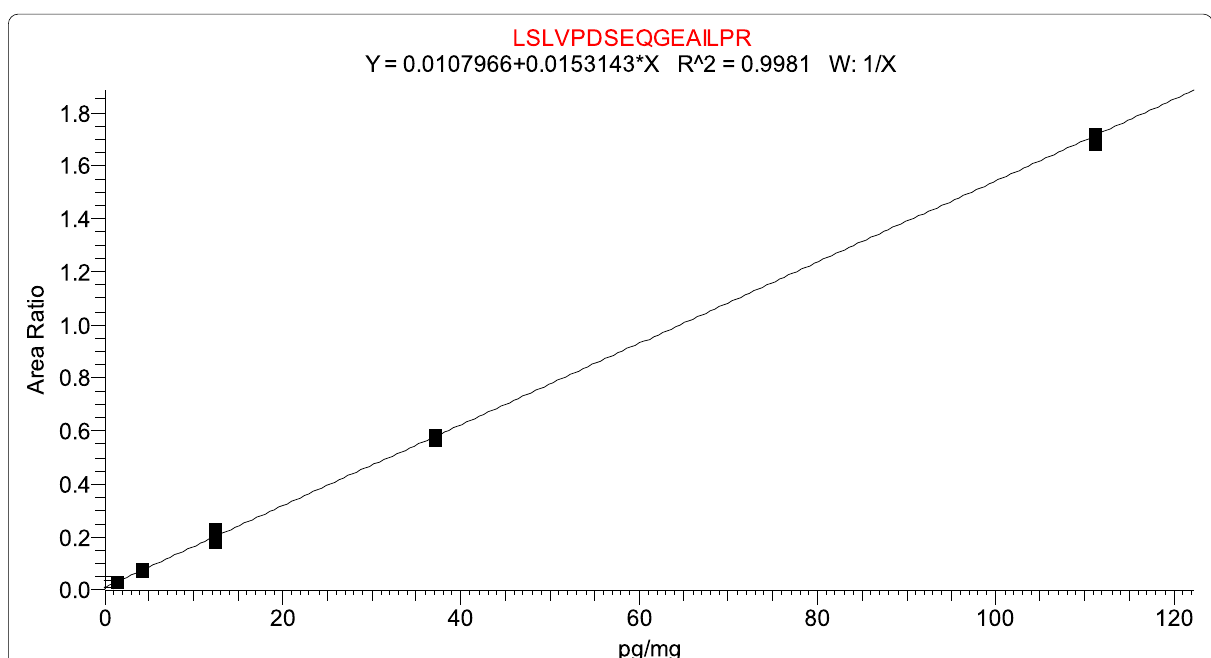
Fig. 6 Standard curve of hCFTR by plotting peak area ratio of light to heavy peptide LSLVPDSEQGEAILPR in mouse lung membrane protein extracts. Streptavidin magnetic beads and biotinylated anti-CFTR antibody were used for IP. hCFTR concentration was 0.5, 1.4, 4.1, 12, 37, to 111 pg per mg tissue for standard 1 to 6, respectively. Calibration curve in linear regression with weighting 1/X was plotted by using Xcalibur